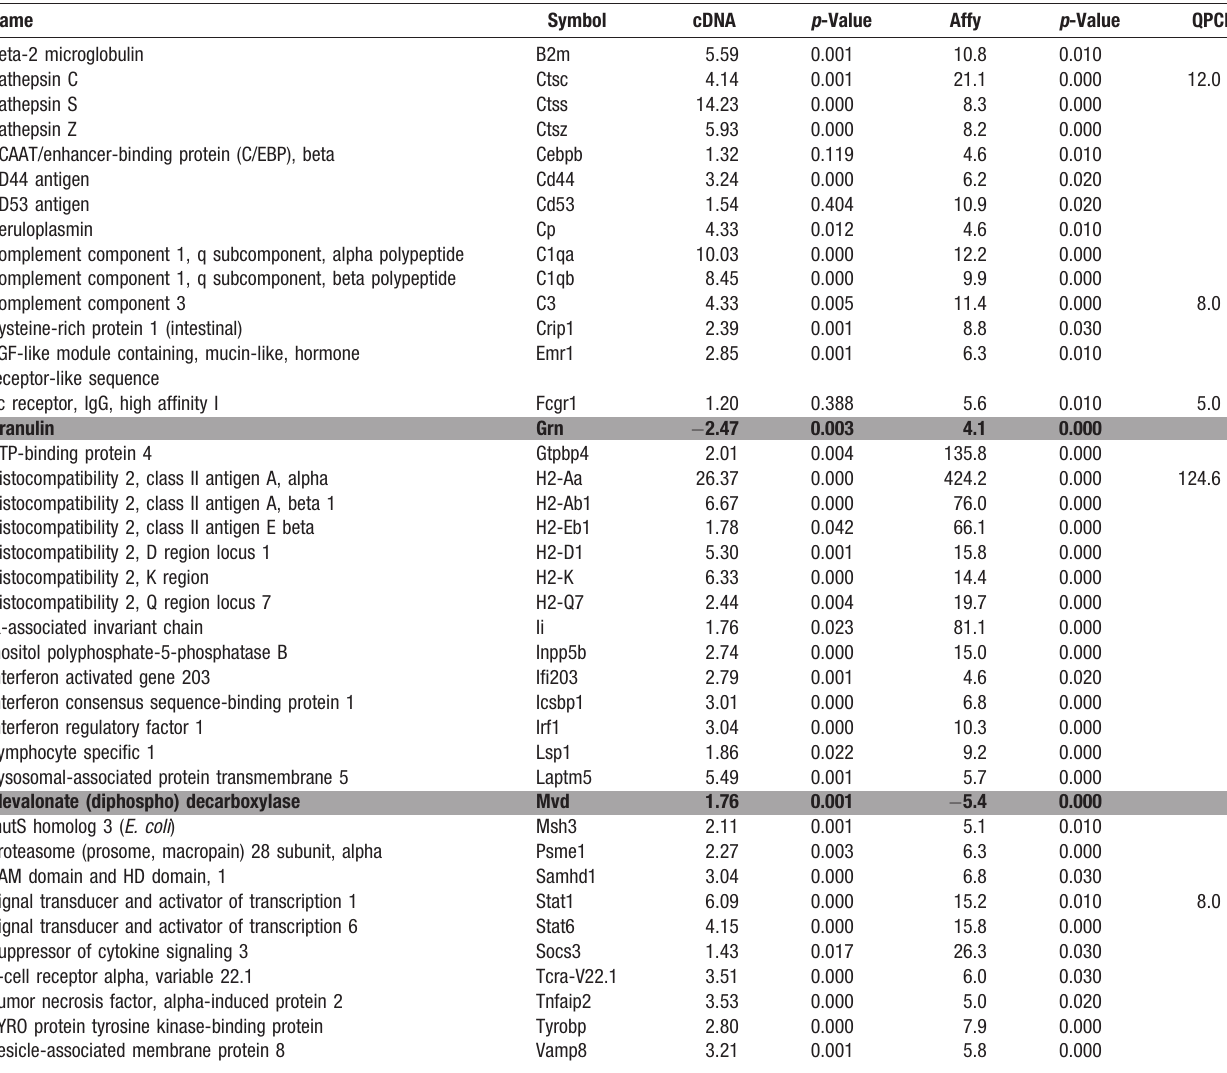
Table 8. Common hits for EAE spinal cord in this study and that by Matejuk et al., (13) obtained through Affymetrix (Affy) and qRT-PCR (QPCR)